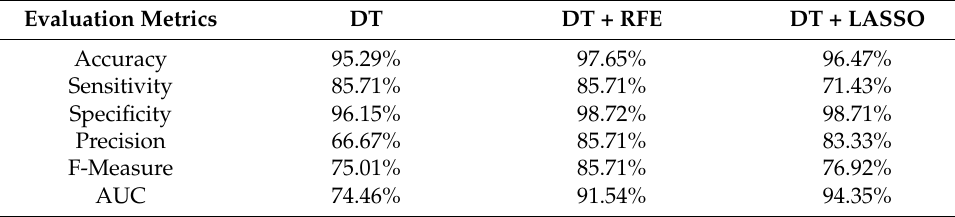
Table 5. Results of DT with the selected